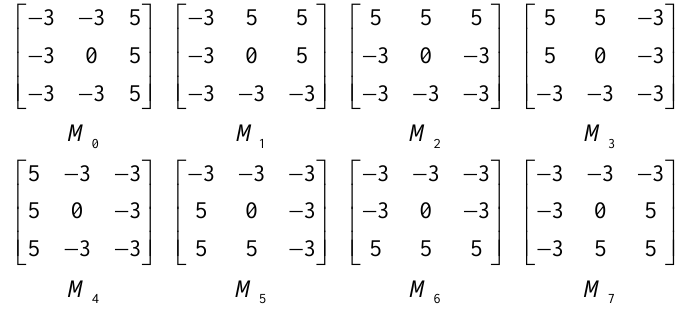
Figure 6. Kirsch compass masks.